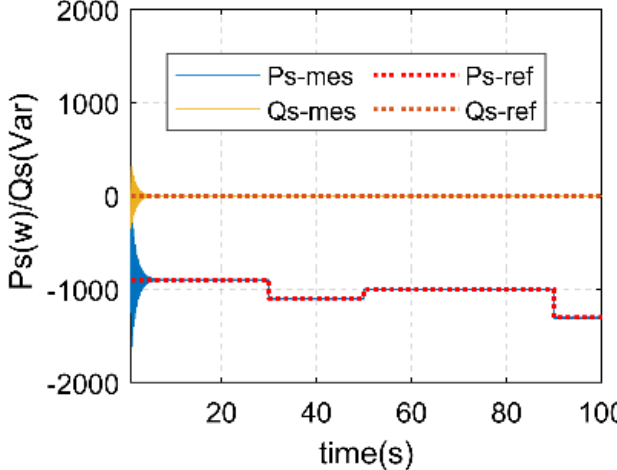
Figure 5. Active and reactive power.